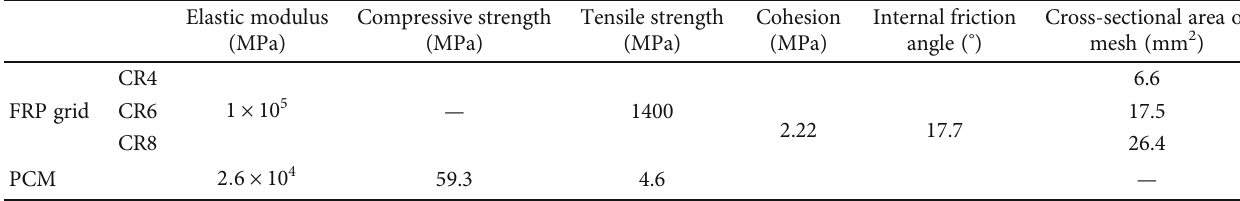
Table 2: Mechanical properties of FRP grids and PCM